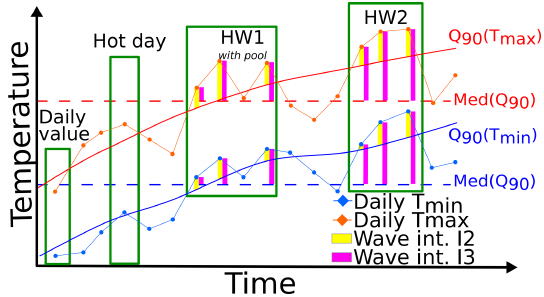
Figure 1. Schema of the detection method and the calculation of the intensities of heat waves, based on temperature anomalies of a calendar day threshold: Q90 ( T max ) and Q90 ( T min ) (I2 calculation), or based on the constant climatological threshold defined by the median of the daily quantiles: Med (Q90 ( T max )) and Med (Q90 ( T min )) (I3